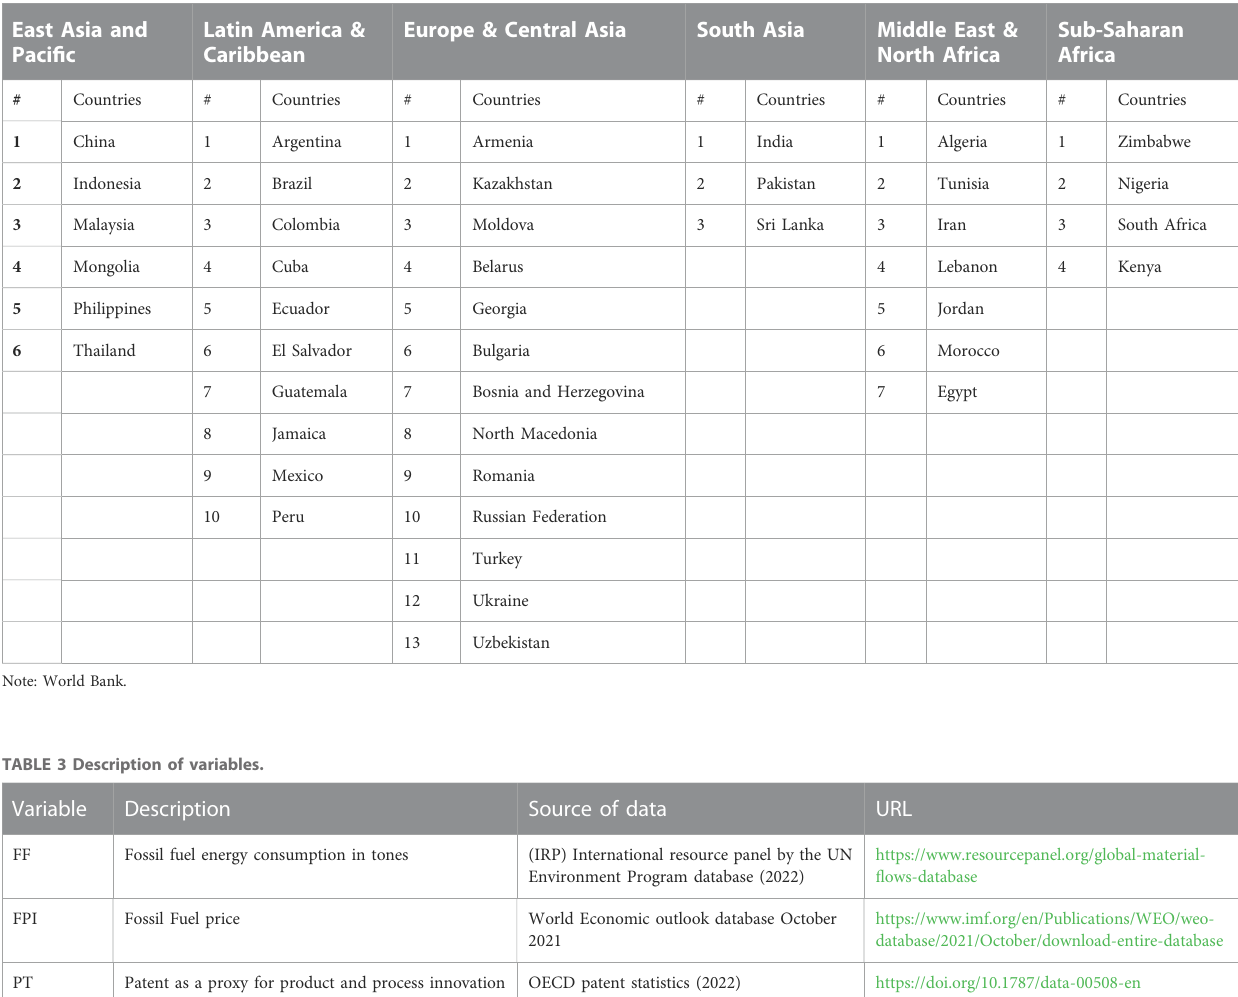
TABLE 2 List of countries by region.